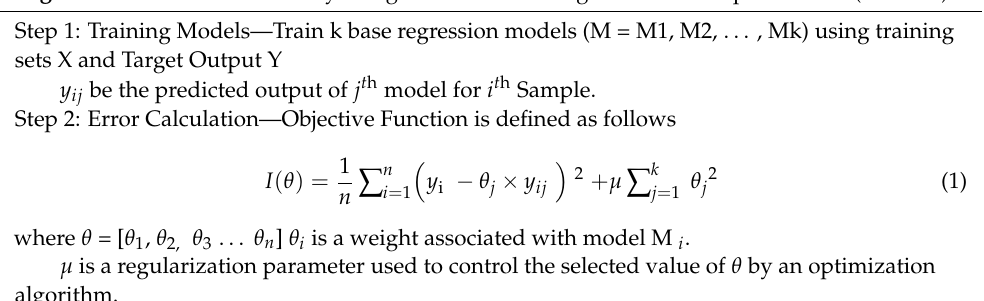
Figure 2. Data flow diagram FERMO algorithm. Algorithm 1 : Content credibility using Fair Ensemble Regression with Optimization